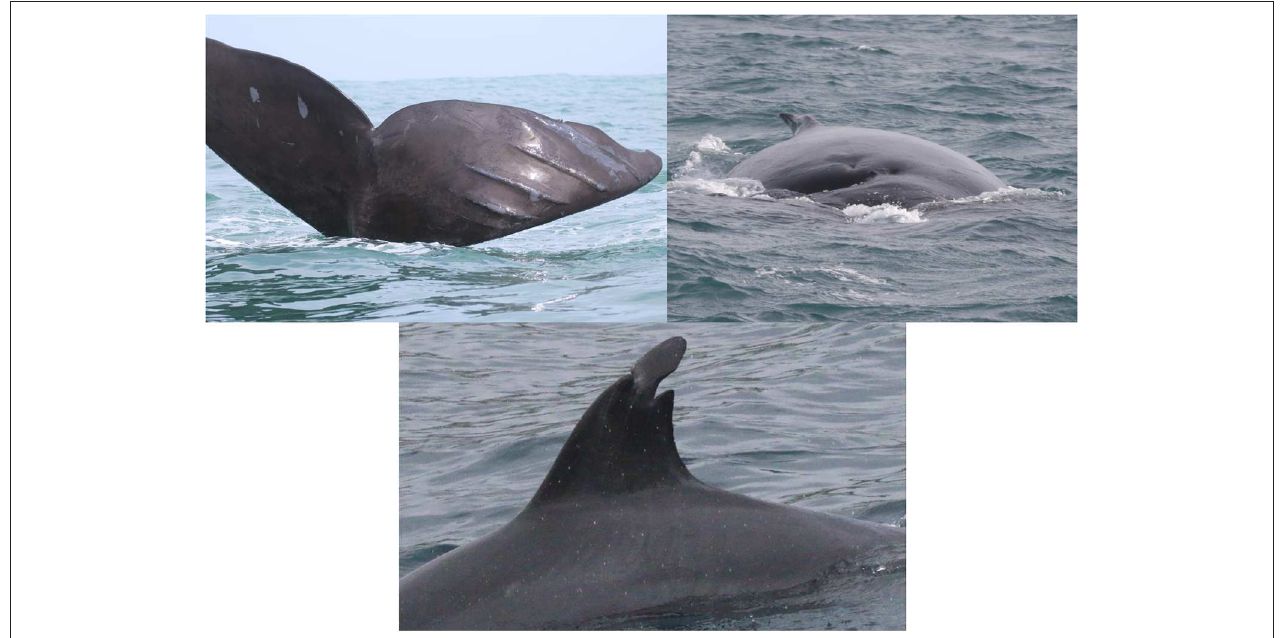
FIGURE 1 | Examples of vessel collision injuries observed on live cetaceans. ( Top left ) Southern right whale ( Eubalaena australis ) with a healed propeller injury (Photo credit: Renée Schoeman). ( Top right ) humpback whale ( Megaptera novaeangliae ) with suspected blunt force trauma (Photo credit: Titus Shaanika). ( Bottom ) bottlenose dolphin ( Tursiops truncatus ) with suspected propeller injury (Photo credit: Michelle Caputo).